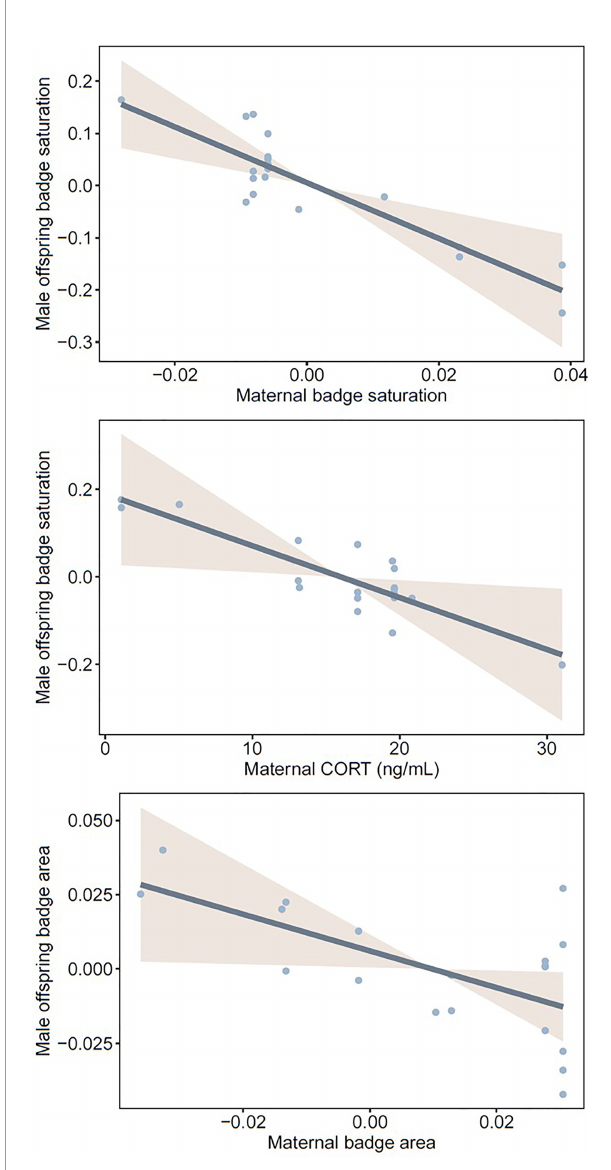
FIGURE 4 | Statistically signi fi cant relationships between male offspring badge quality (saturation and area) and either maternal badge quality (saturation and area) or maternal baseline CORT during pregnancy. Badge saturation was corrected for body temperature at the time of measurement, and badge area was quanti fi ed in relation to head area (see Methods ( Figure 2 ). Although this effect was strong, limitations in the sampling regime along with the correlative nature of the analyses may reduce the generality of these observations.